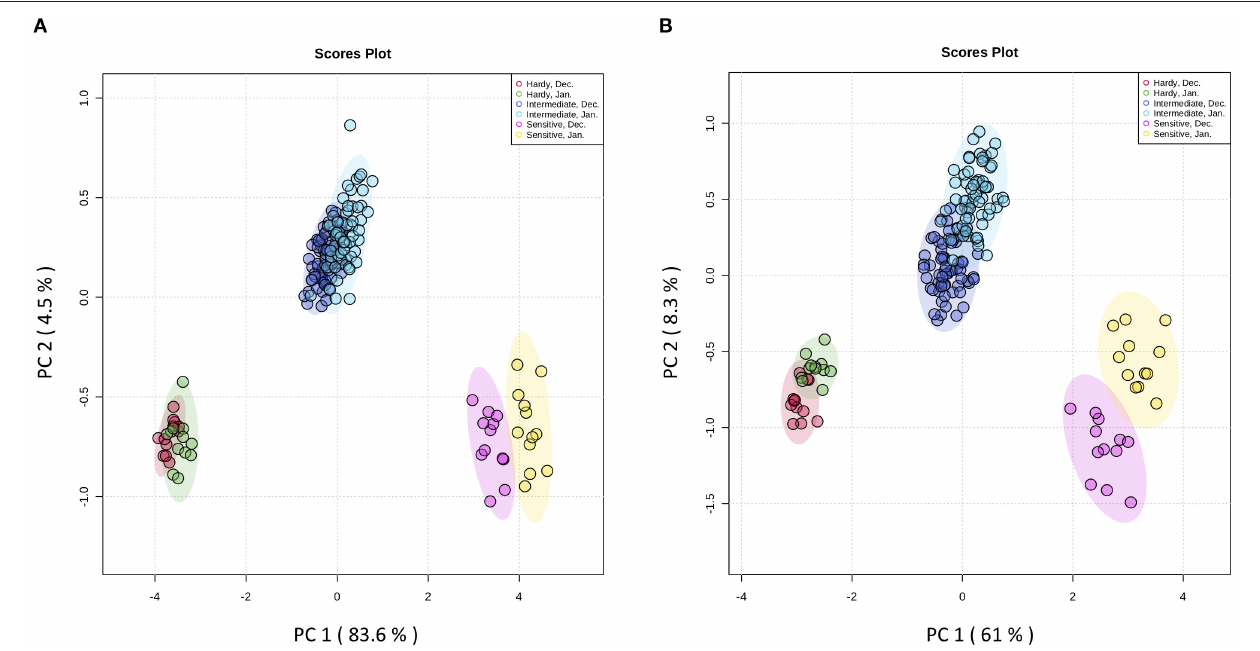
FIGURE 3 | Score plots from PCA of metabolites in stem (A) and bud (B) of fifteen pomegranate genotypes in December and January of two developmental cycles. The first two principal components (PC1 and PC2) are shown. Stem and bud samples in each time-point are represented by circles with different colors. Each point represents an individual biological replicate ( n = 3). Samples were segregated with regards to genotype and time-point. Red circles: samples from hardy genotypes in December; green circles: samples from hardy genotypes in January; purple circles: samples from intermediate genotypes in December; blue circles: samples from intermediate genotypes in January; pink circles: samples from sensitive genotypes in December; yellow circles: samples from sensitive genotypes in January.